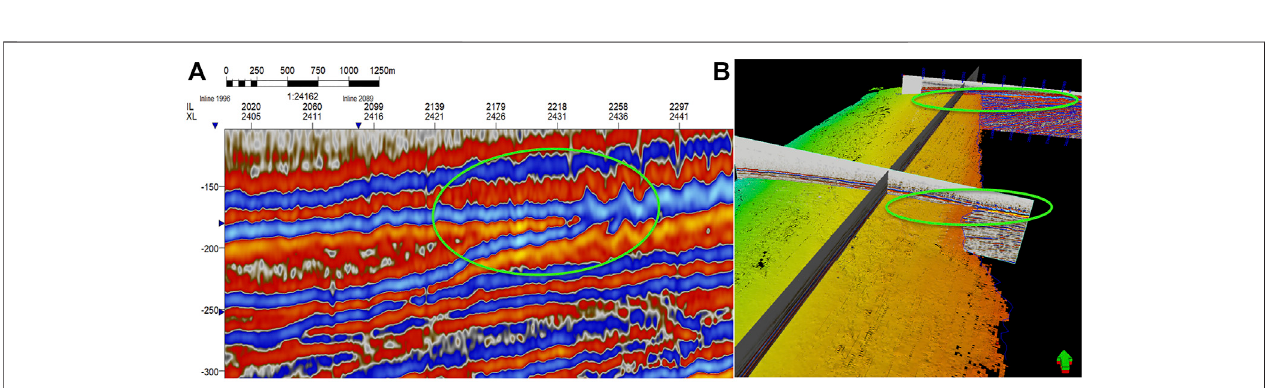
FIGURE 4 | 3D view of pinchout point with contour in the horizon (A) focus on pinchout; (B) 3D connection of points to form pinchout and the horizon.